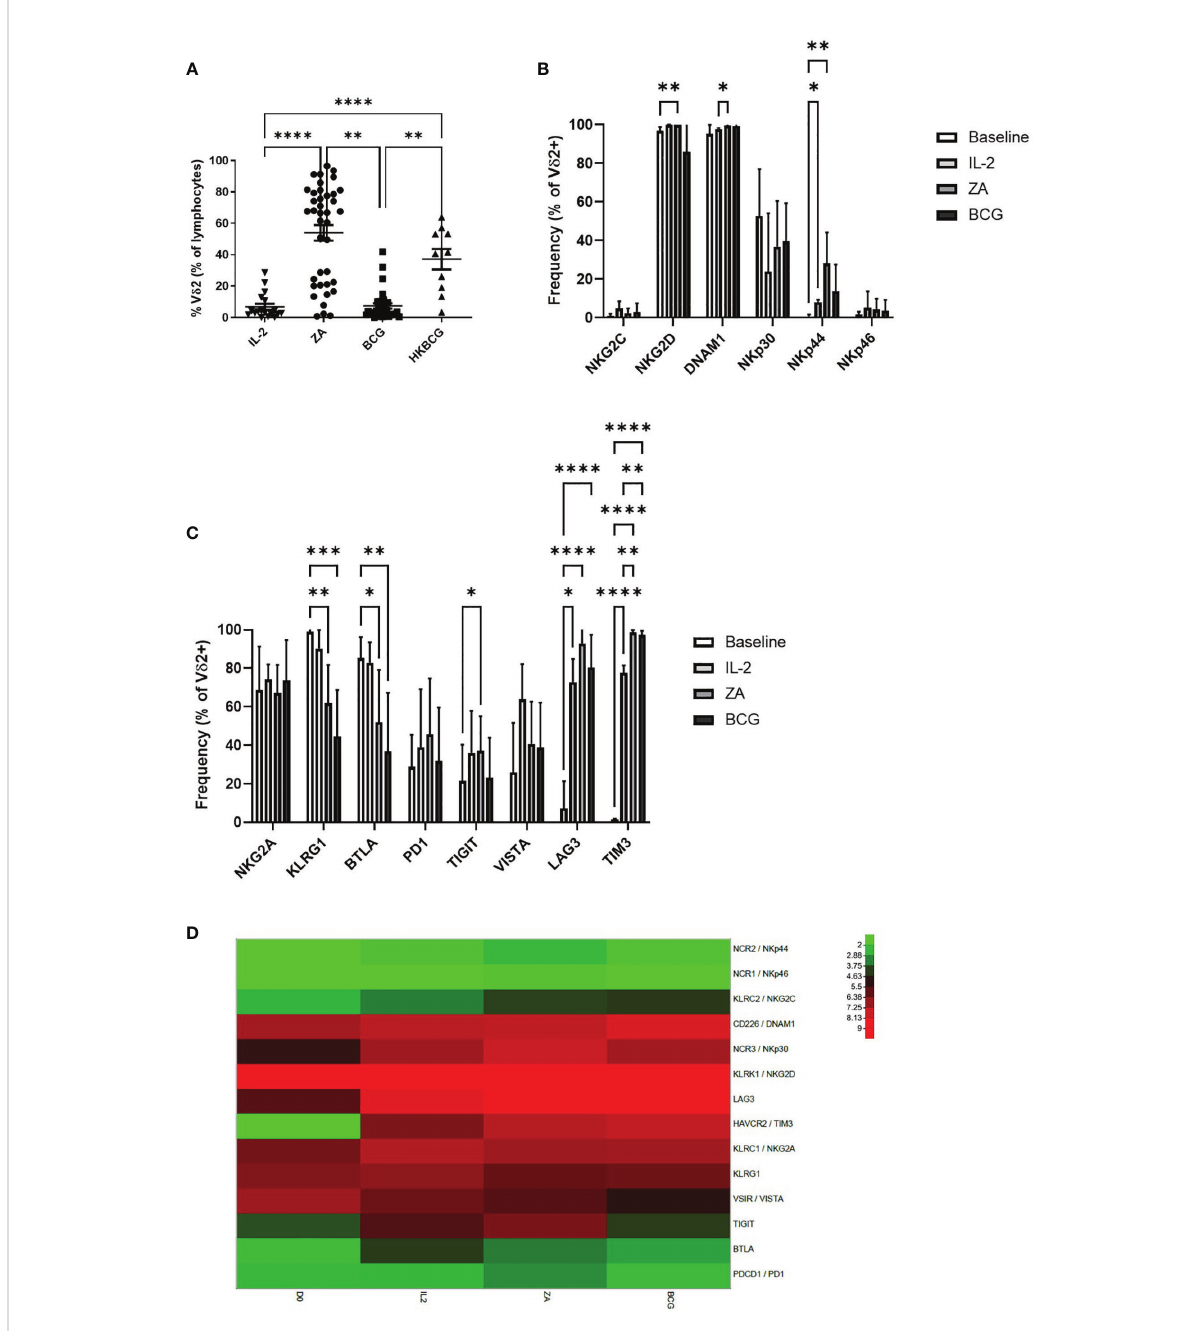
FIGURE 3 Frequency of V d 2 cells as a percentage of live cells was assessed by fl ow cytometry following 14 days stimulation with IL-2 alone or IL-2 with ZA, BCG or HK-BCG. N=10-39, **p<0.005, ****p<0.0001, non-parametric analysis of variance with Tukey ’ s post hoc for multiple pairwise comparisons (A) . Expression of NK associated activatory markers (B) and inhibitory checkpoint receptors (C) was determined on V g 9V d 2 T-cells in PBMC stimulated for 14 days with IL-2 alone, ZA or BCG, both with IL-2, using fl ow cytometry. N=10, *p<0.05, **p<0.005, ***p<0.0005, ****p<0.0001, non-parametric mixed effects analysis with Tukey ’ s post hoc for multiple pairwise comparisons. Expression of activatory and inhibitory receptors was determined in V g 9V d 2 T-cells from 6 donors at baseline (D0) and following stimulation for 14 days with IL-2 alone (IL2), ZA (ZA) or BCG (BCG), both with IL-2, using RNAseq (D)